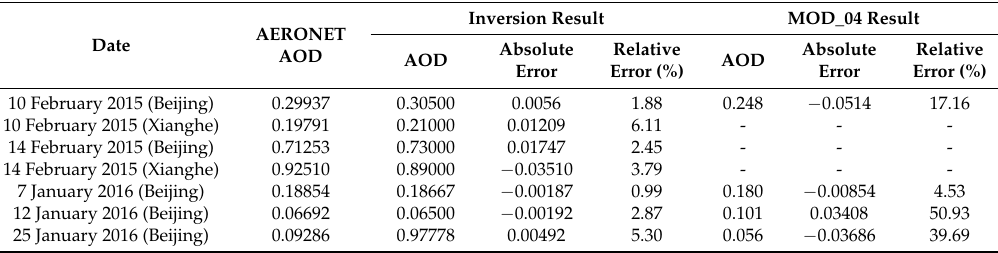
Table 8. The AOD comparison of inversion and